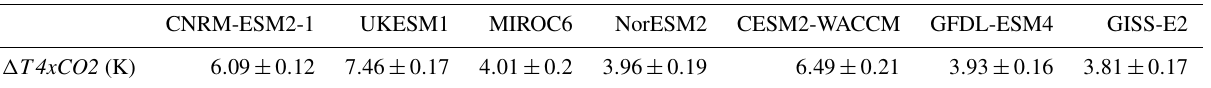
Table 5. Change in global mean surface temperature following an abrupt quadrupling of CO 2 concentrations. The difference between abrupt- 4xCO2 and piControl is averaged over the years 121–150. Uncertainties refer to the standard deviation of the interannual